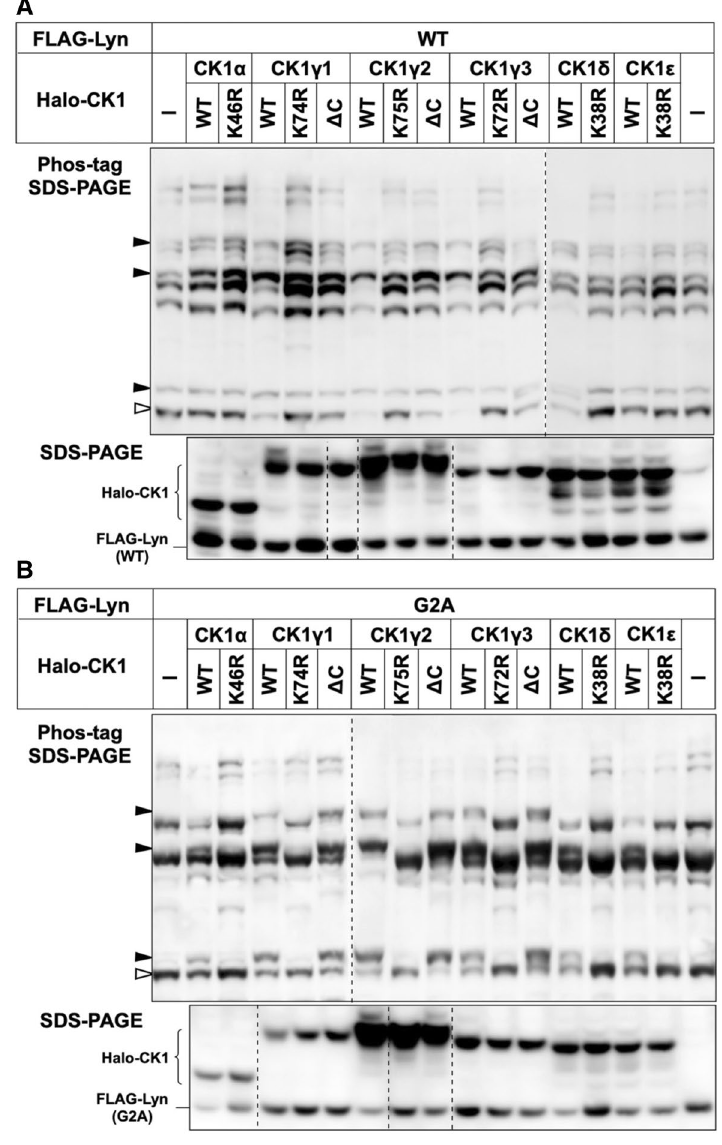
Figure 6. Phos-tag banding image of Lyn co-expressed with CK1. ( A ) FLAG-tagged LYN WT and Halo- tagged CK1 (WT, kinase-dead or ΔC mutant) co-expressed in HEK293 cells were analyzed by using Phos-tag SDS-PAGE (20 μM Zn 2+ –Phos-tag and 7% w/v polyacrylamide) followed by immunoblotting with anti-FLAG antibody (upper panel). All protein expressions in HEK293 cells were confirmed by SDS-PAGE followed by immunoblotting with a cocktail of anti-FLAG antibody and anti-HaloTag antibody (lower panel). ( B ) FLAG- tagged Lyn G2A mutant and Halo-tagged CK1 (WT, kinase-dead or ΔC mutant) co-expressed in HEK293 cells were analyzed in the same manner as ( A ). Open arrowhead: nonphosphorylated species. Closed arrowhead: phosphospecies containing a phosphorylated Ser-13 residue. ΔC: deletion of Cys-406, Cys-407, and Cys-408 in CK1γ1; deletion of Cys-399, Cys-400, and Cys-401 in CK1γ2; deletion of Cys-431, Cys-432, and Cys-433 in CK1γ3. The raw images shown in Supplementary Figure S11 were spliced to arrange the lanes appropriately. The positions of the splices are indicated by vertical dashed